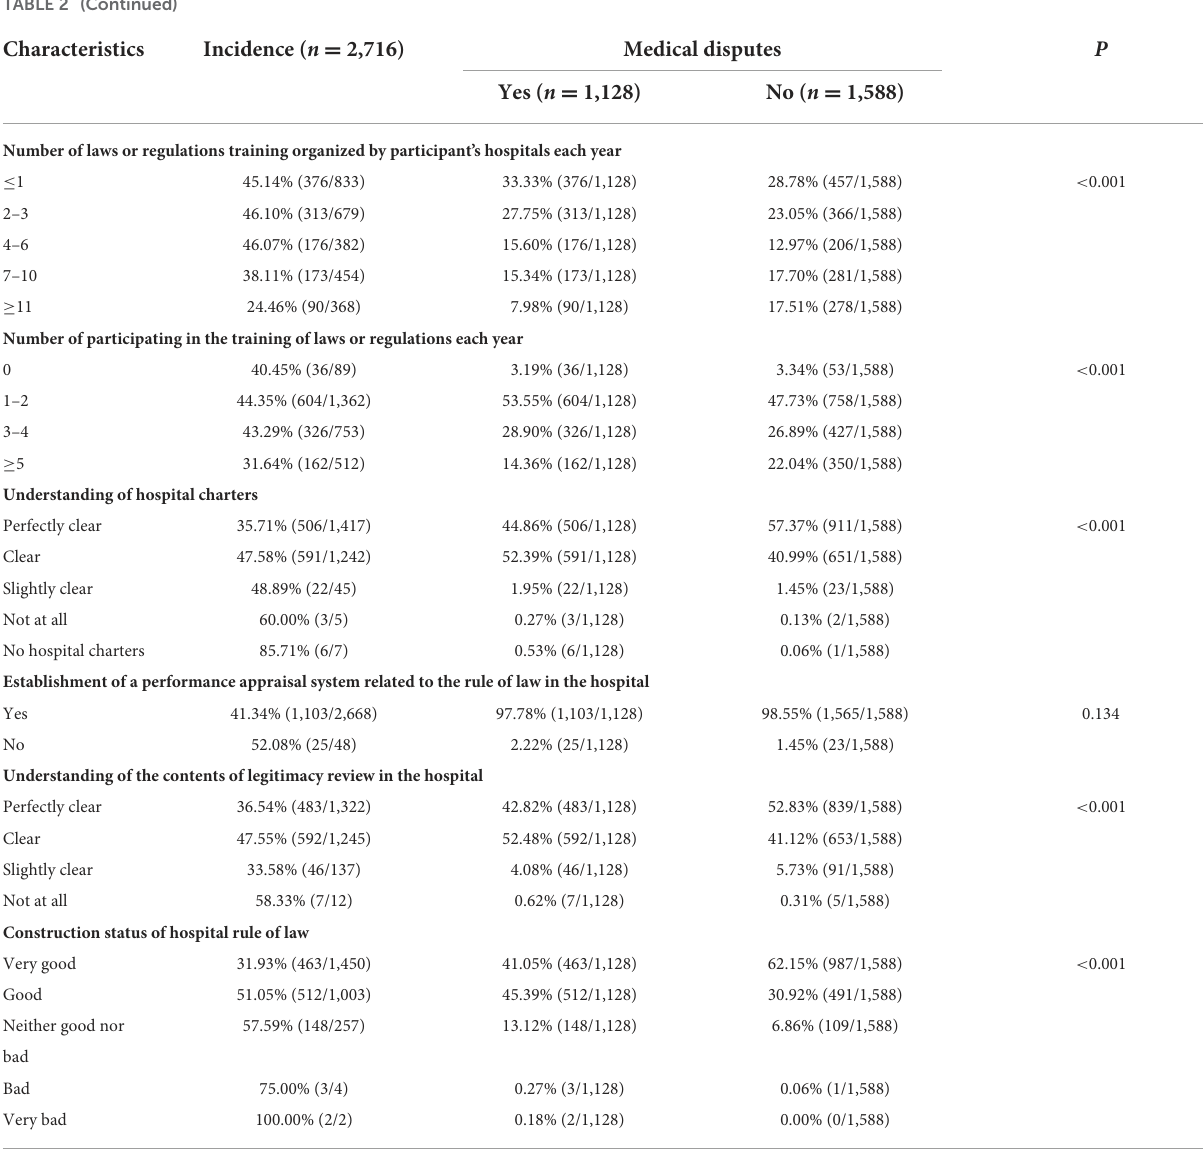
The Brier scores were both 0.22 in the training and validation groups, and the Brier-scaled scores were 8.66 and 9.43%, respectively ( Table 4). The area under curve